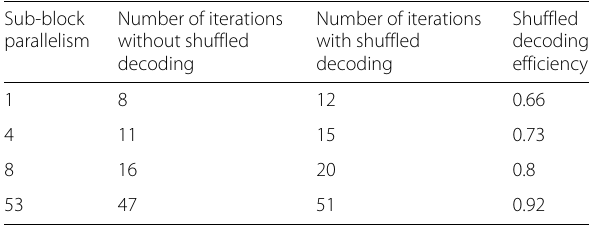
Table 1 Comparison of necessary number of decoding